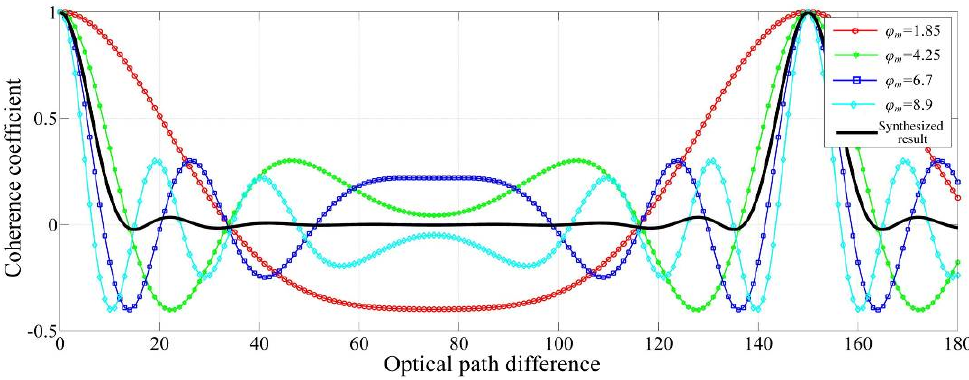
Figure 2. Synthesized coherent function as a function of the optical path difference.